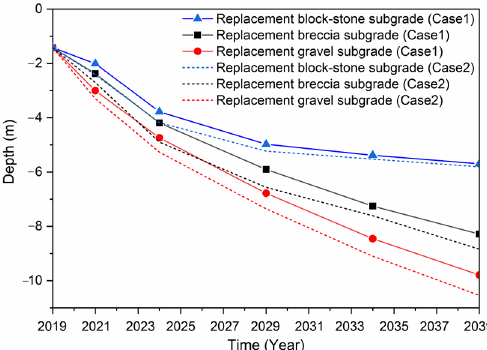
Figure 13. Comparison of permafrost table changes under the road centerlines of the three subgrade structures in Case 1 and Case 2.